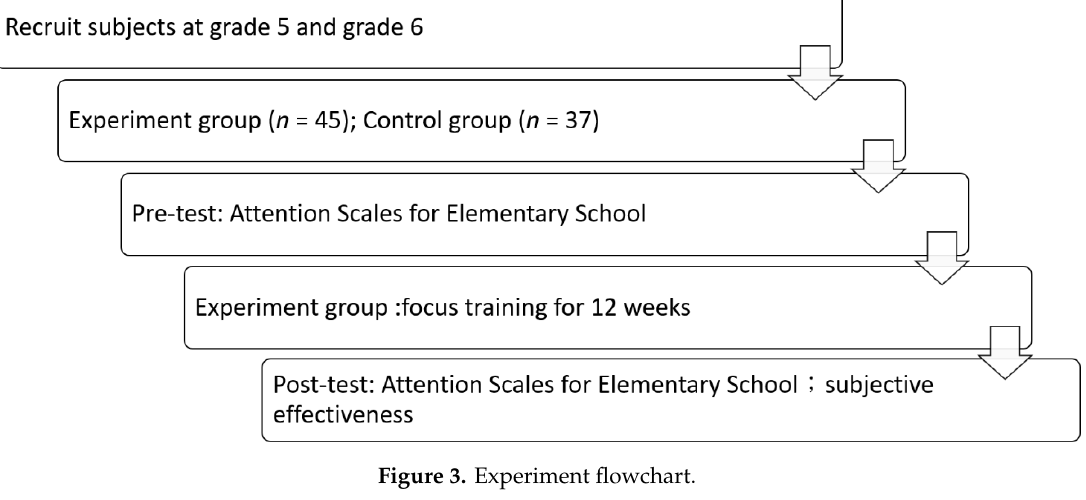
Figure 3. Experiment flowchart.